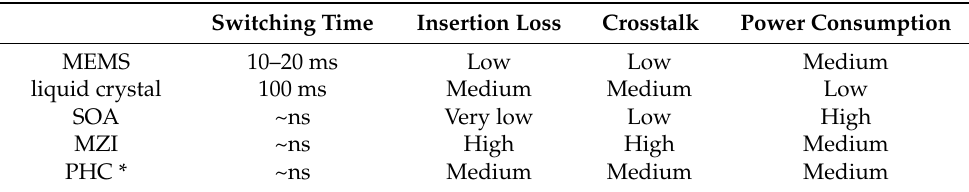
Table 1. Comparison of the performance of different optical switches. Switching Time Insertion Loss Crosstalk Power Consumption MEMS 10–20 ms Low Low Medium liquid crystal